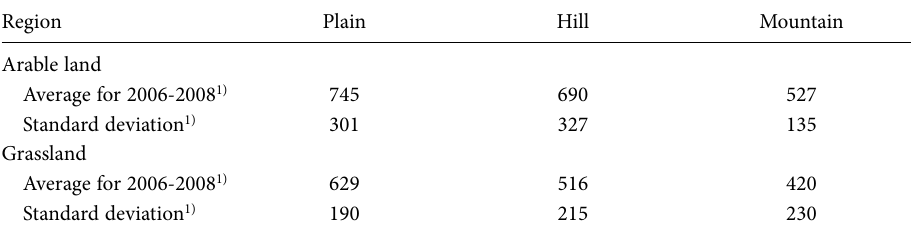
Calculated on the basis of the sample of specialised arable and grassland farms from Agroscope